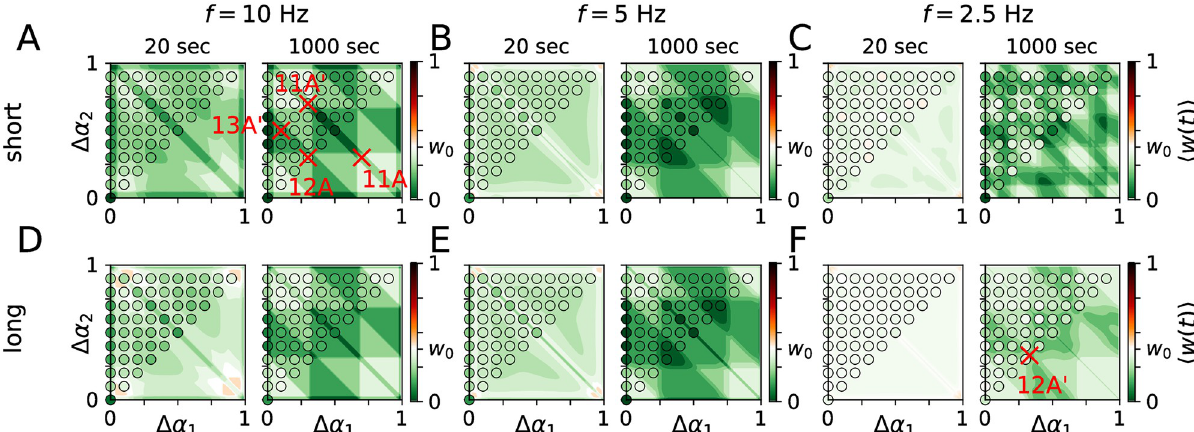
Fig 6. Mean synaptic weight during single-pulse PMCS depends on pulse duration and stimulation frequency. Theoretical predictions (color maps) obtained from Eq 4 after 20 sec and 1000 sec of PMCS are compared to simulation results for the LIF network model (filled circles). w 0 = 0.38 is the mean synaptic weight prior to stimulation. Labeled columns show results for different stimulation frequencies: f = 10.0 Hz (A, D), f = 5.0 Hz (B, E), and f = 2.5 Hz (C, F). Rows show results for short pulses ( d e = 1, top) and long pulses ( d e = 20, bottom) (Methods). Simulated spike trains, snapshots of the connectivity matrix, and theoretical predictions of the block structure of the synaptic weight matrix are shown below for the parameter sets marked by red crosses (see red figure labels). Parameters: A stim =